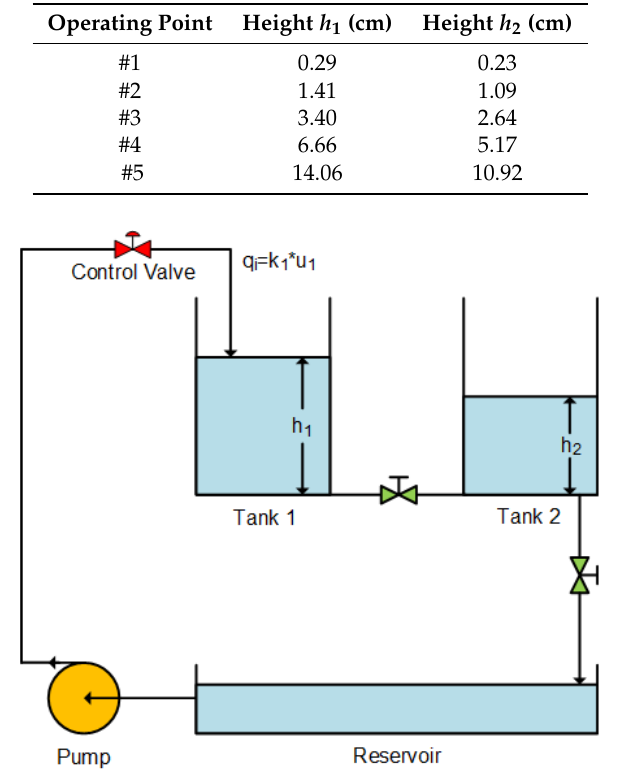
Table 2. Operating points of the two interacting tank system.